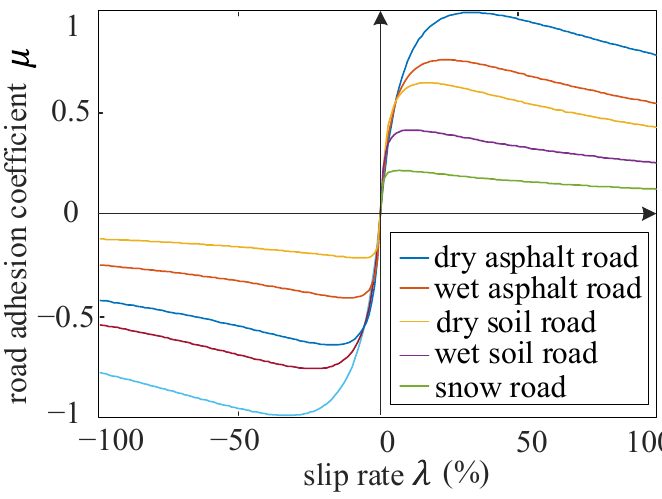
Figure 12. µ - λ of different road Figure 12. 𝜇 - 𝜆 of different road surface.